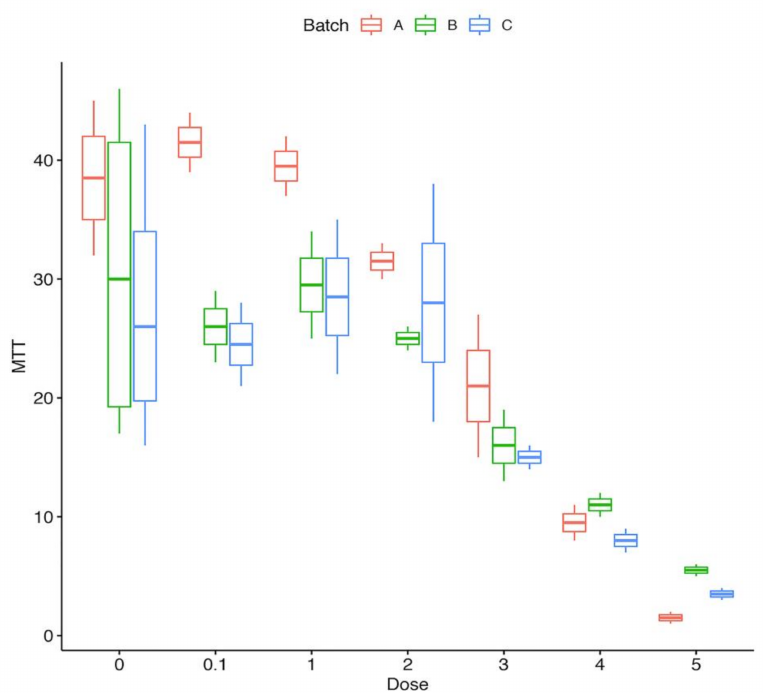
Figure 2. Effect of cocaine on cell growth. The boxplot shows the cell vitality, measured by caine. We present data for three experiments, each in triplicate (A, B, and